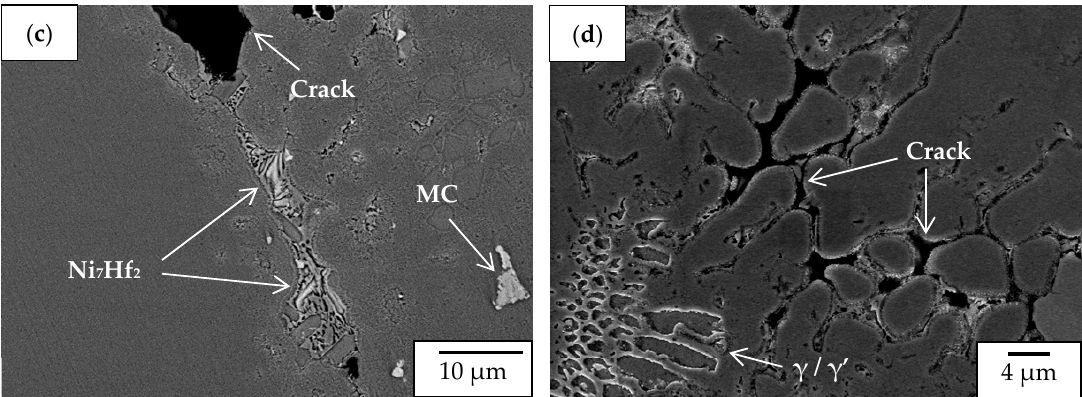
Figure 5. ( a ) Liquation cracks at the HAZ of the Mar-M004 weld; ( b ) crack propagating along the interface of the MC carbide and matrix; ( c ) lamellar white phases ahead of liquation crack; ( d ) solidification cracking along γ - γ′ colonies.